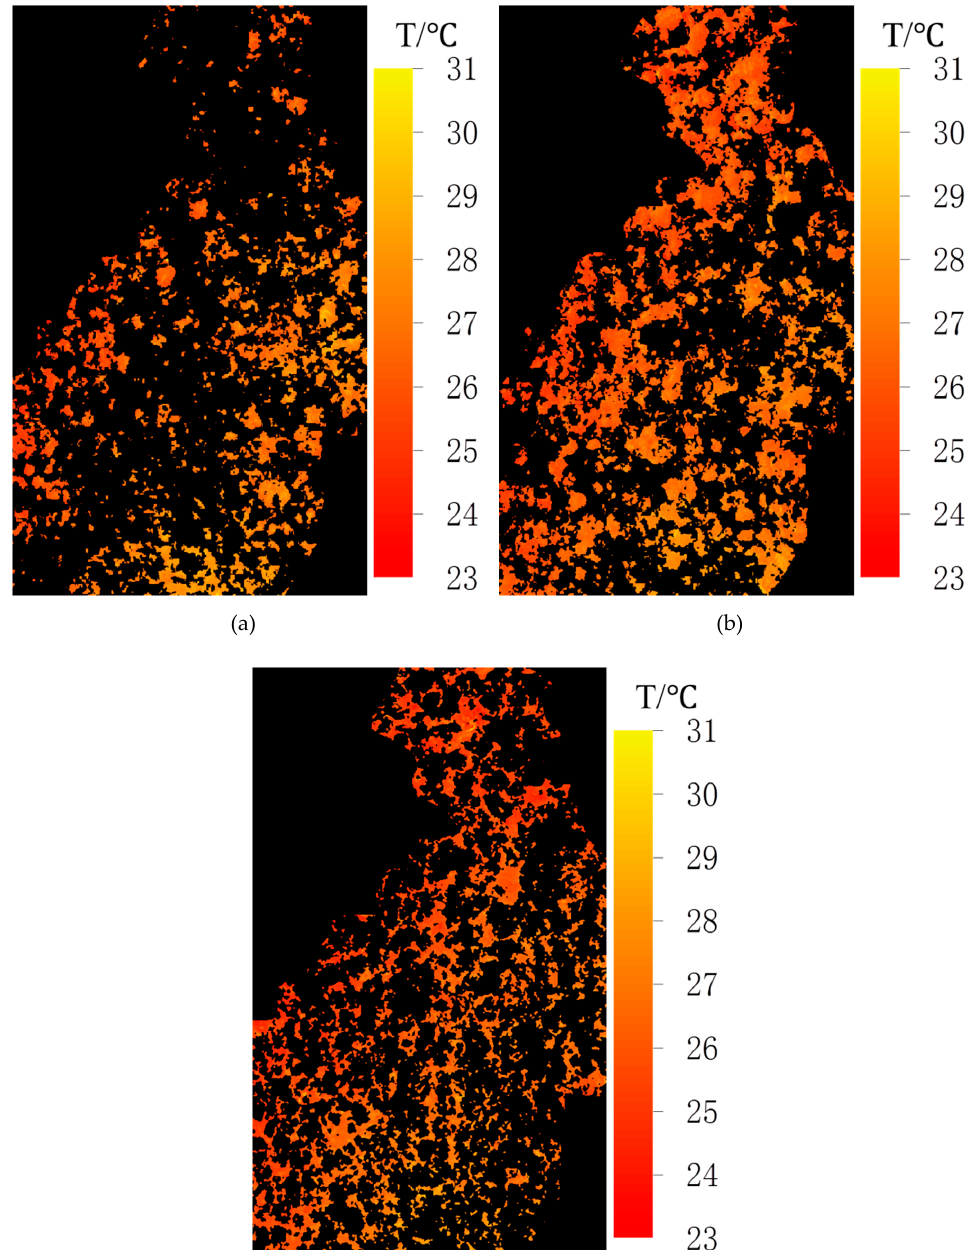
Figure 2. Spatial distribution of the surface temperatures of the ( a ) liana-infested areas ( b ) non-liana infested areas, and ( c ) forest gaps in the study area. Land cover classes are after Li et al.